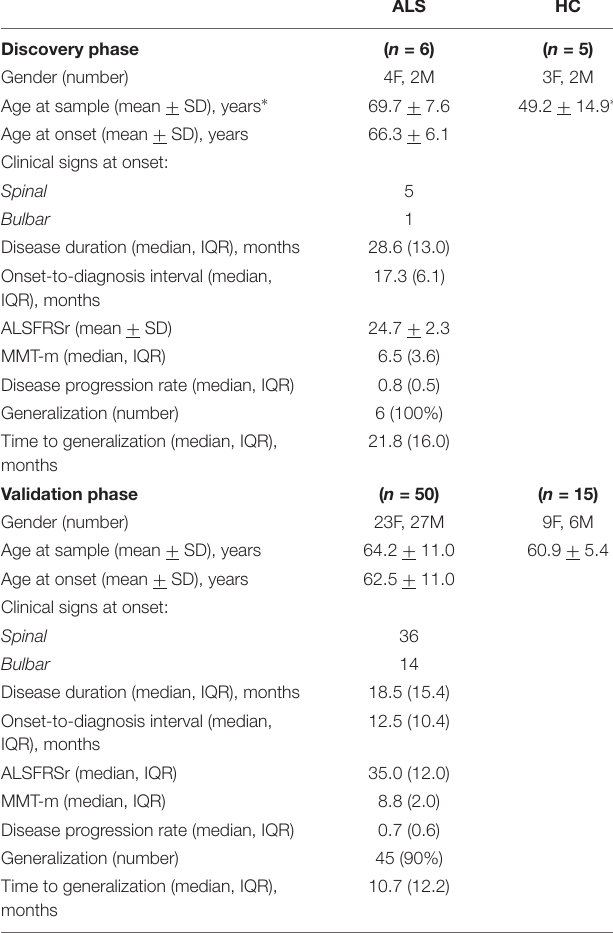
TABLE 1 | Demographic and clinical characteristics of the study